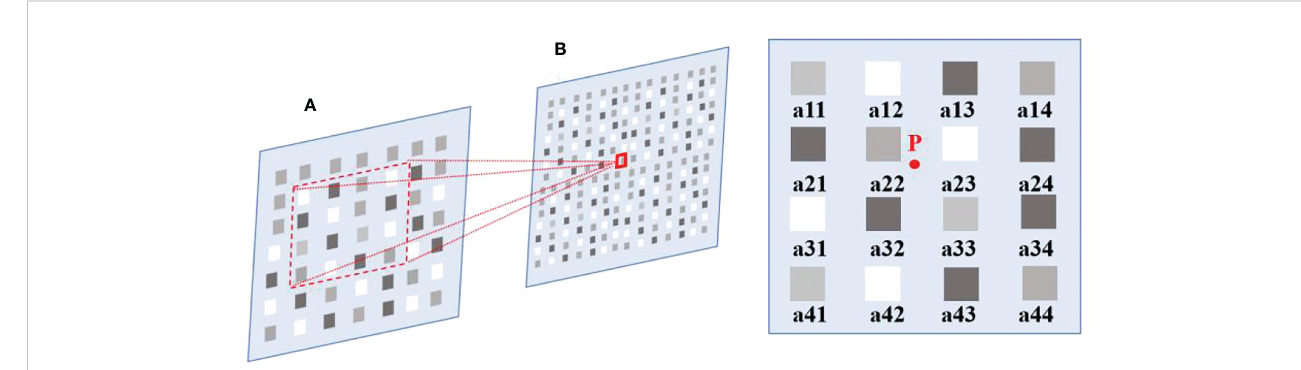
FIGURE 1 Position of the last 16 pixels of point P